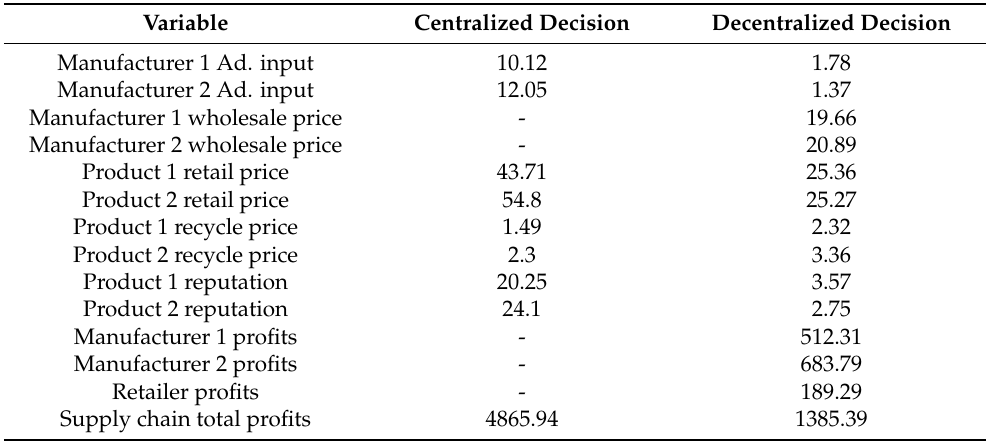
Table 2. Comparison of optimal decisions for closed-loop supply chains under steady-state conditions.